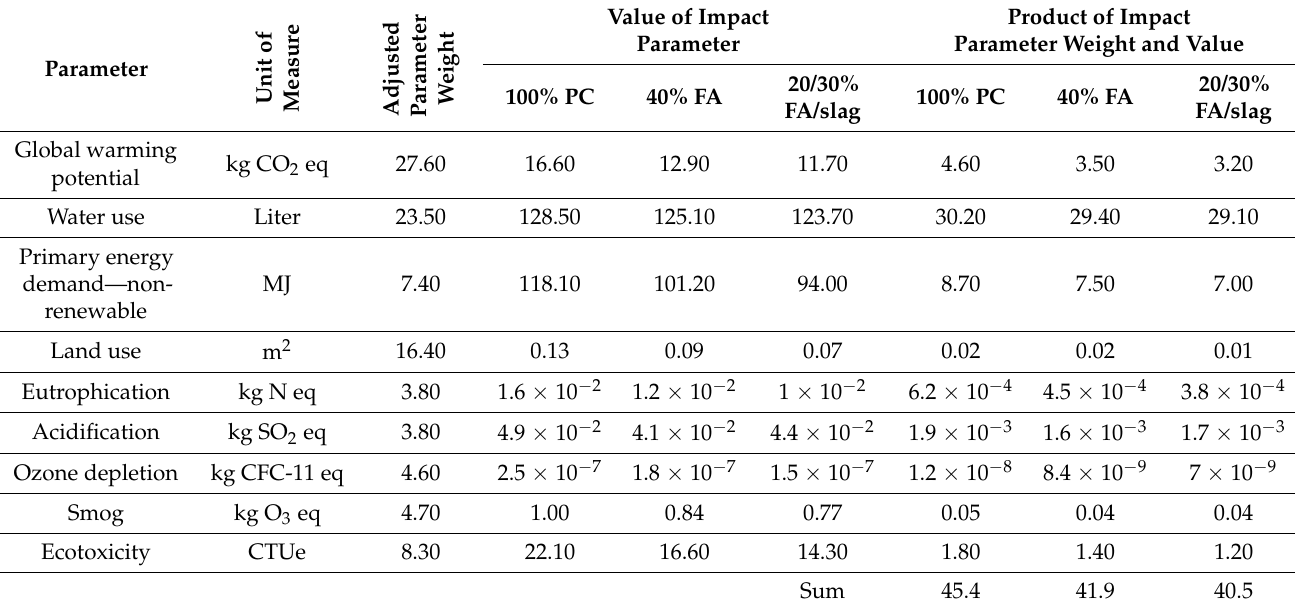
Table 4. LCIA-related calculations for structural